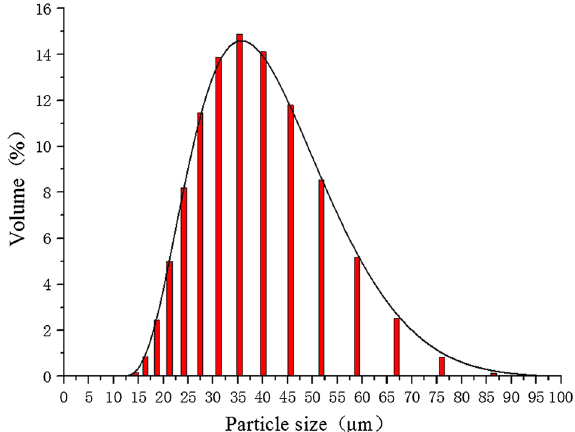
Figure 3. Particle size distribution of powder.